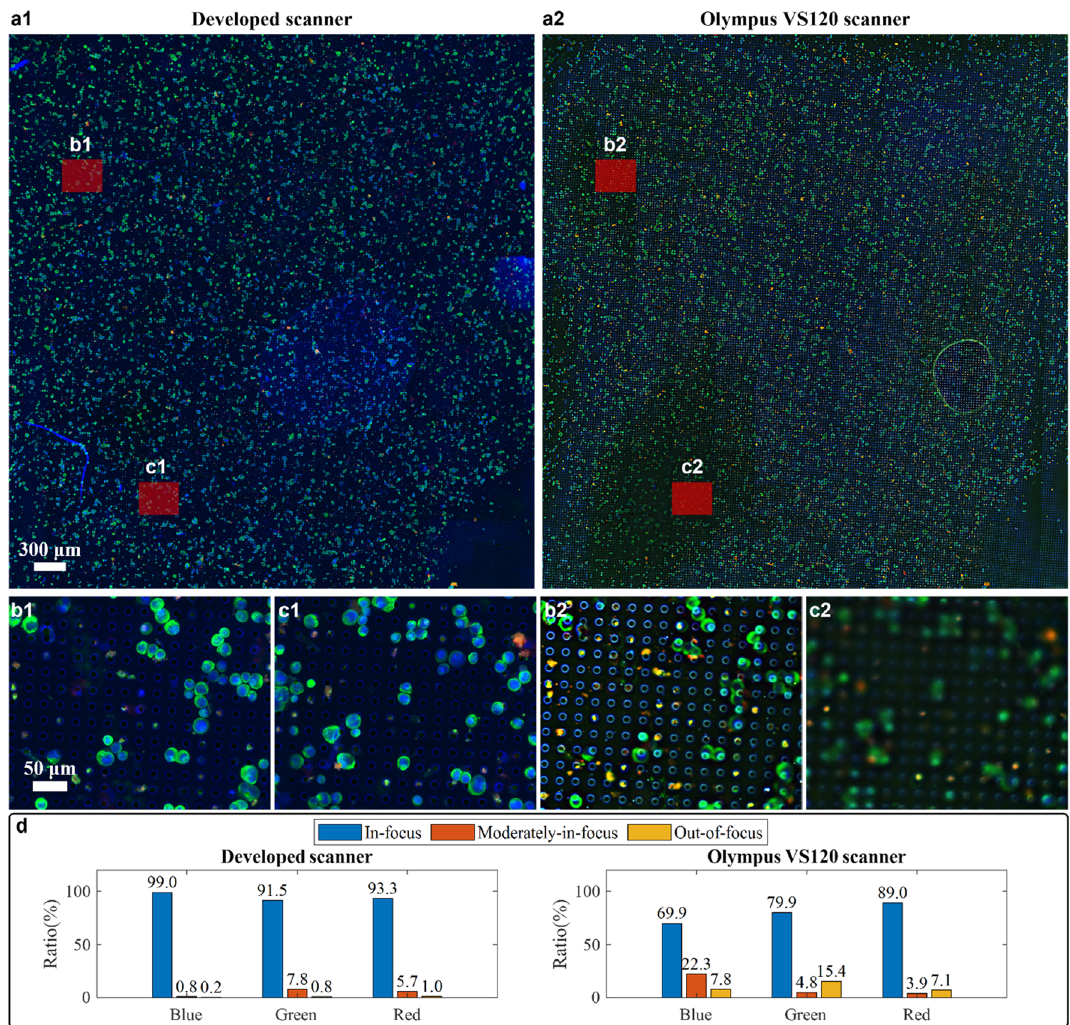
Figure 4. Comparison of the whole slide image focus quality by our developed scanner and Olympus VS120 scanner. ( a1 ) Whole slide image (WSI) of a model sample under 20X objective from our developed scanner. ( a2 ) WSI of the same model sample under 20X objective from Olympus VS120 scanner. ( b1 , b2 ) and ( c1 , c2 ) are the zoom-in on the same regions from two WSIs. Their area size is the same as the image tile from VS120 scanner, 366 μm × 287 μm. ( d ) Quantitative analysis of focus quality of WSI from both scanners in blue, green and red